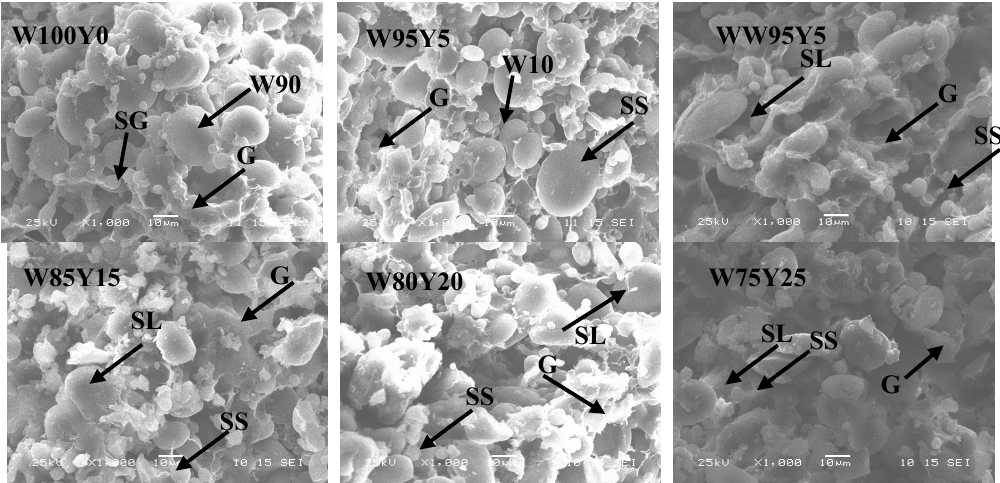
Figure 4. Scanning electron micrographs of dough substituted with different level of yam flour (1000×). SL: large starch granules, SS: small starch granules, and G: gluten network.